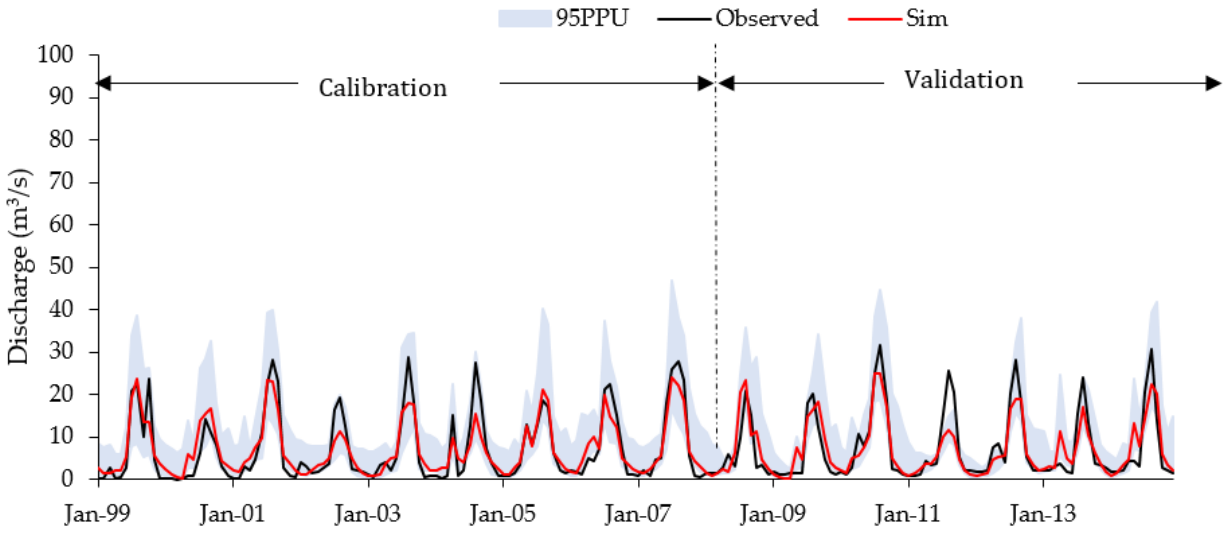
Figure 4. Stream flow calibration and validation result of Katar subbasin at Abura station (1999–2014).